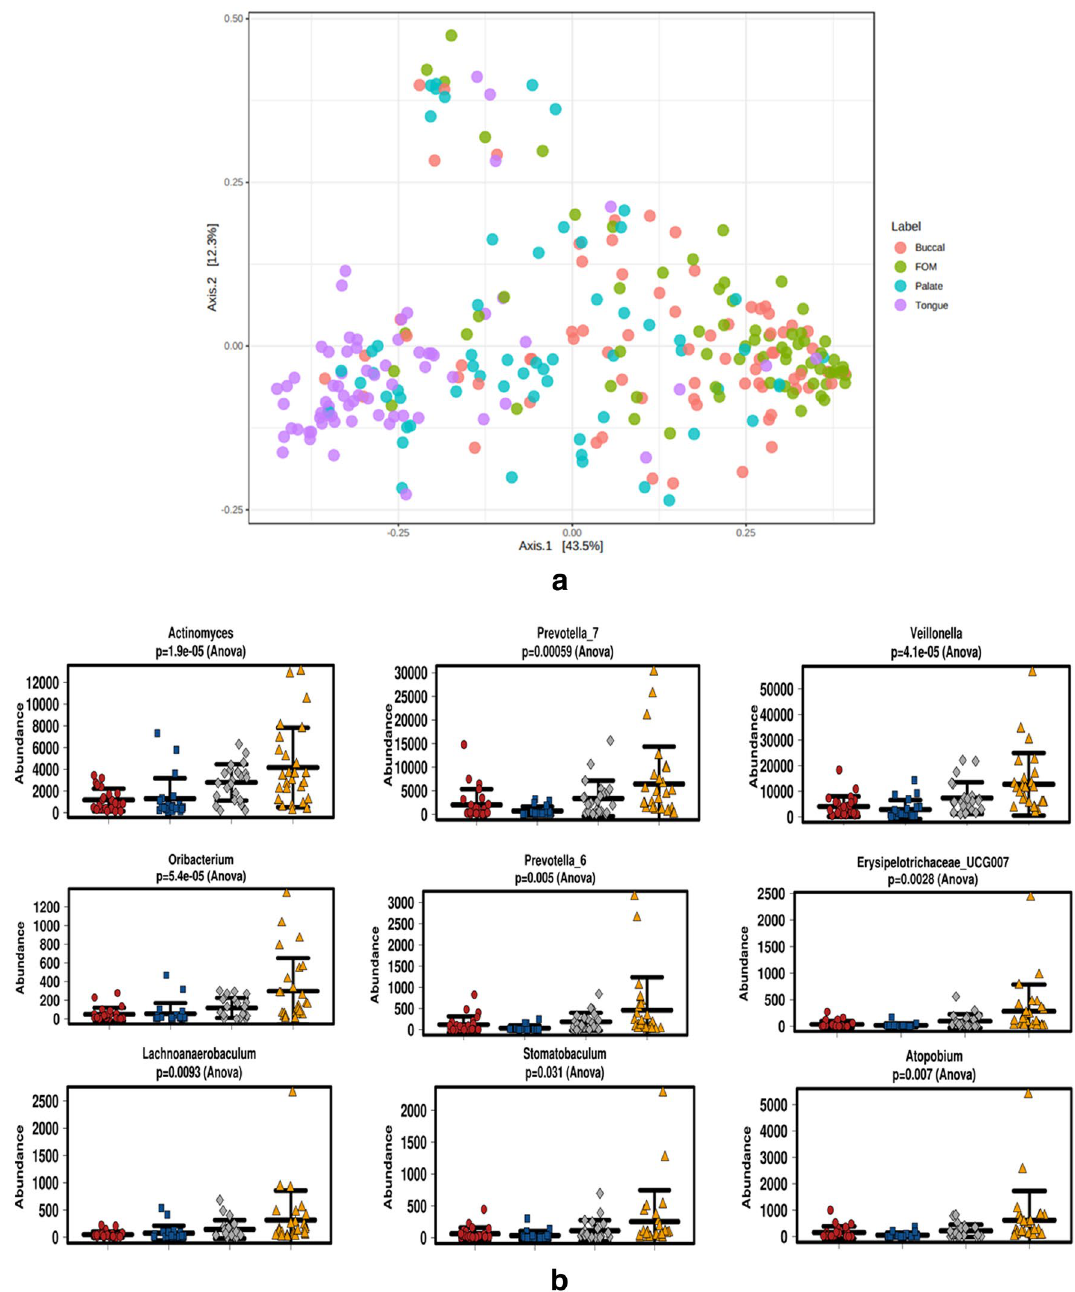
Figure 3. ( a ) β diversity between the oral mucosal regions. Significant β diversity between the oral mucosal regions ( p -value < 0.001). R 2 = 0.22. The tongue microbiome (purple) is most distinct. Non-keratinised buccal and floor of the mouth mucosa are the most clustered together while the palatal microbiome is centrally bridged. ( b ) Tongue microbiome abundances amongst the oral Sudanese microbiomes. Red = buccal cheek, blue = floor of the mouth, grey = hard palate and gold = dorsum tongue. Actinomyces, Prevotella, Veillonella are amongst the most significantly abundant genera of tongue microbiome. ( c ) Abundant genera in the other mucosal locations. Red = buccal, blue = floor of the mouth, grey = palate, and gold = dorsum tongue. Actinobacillus and Bergeyella are most abundant in the floor of the mouth, Kingella in the palate and Shigella in the buccal mucosa. ( d ) Canonical correspondence analysis (CCA) plot of users (blue) and non-users (red) of Toombak. Oral health was utilised as the known gradient in minimising matrix errors in OTU–oral health relationships. Accounting for oral health, Toombak harboured oral microbiome differences that could be appreciated compared to